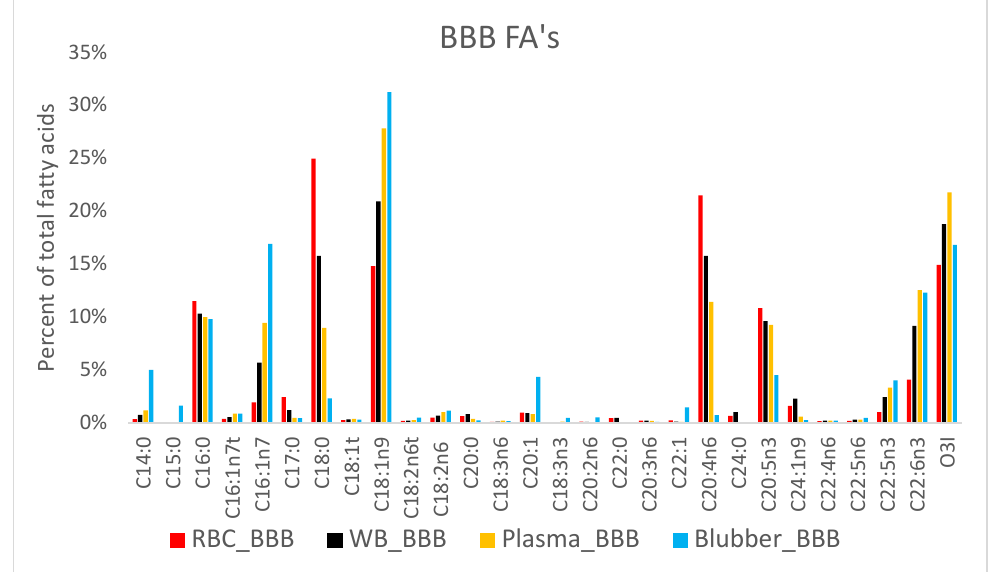
Figure 3. FA profiles from Bristol Bay beluga (BBB, n = 9) by tissue compartment (RBC, WB, plasma and blubber). For OBB FA comparison, blubber FAs profiles from archived OBB samples and select OBB dietary FAs were included with tissue components (Figure 4).